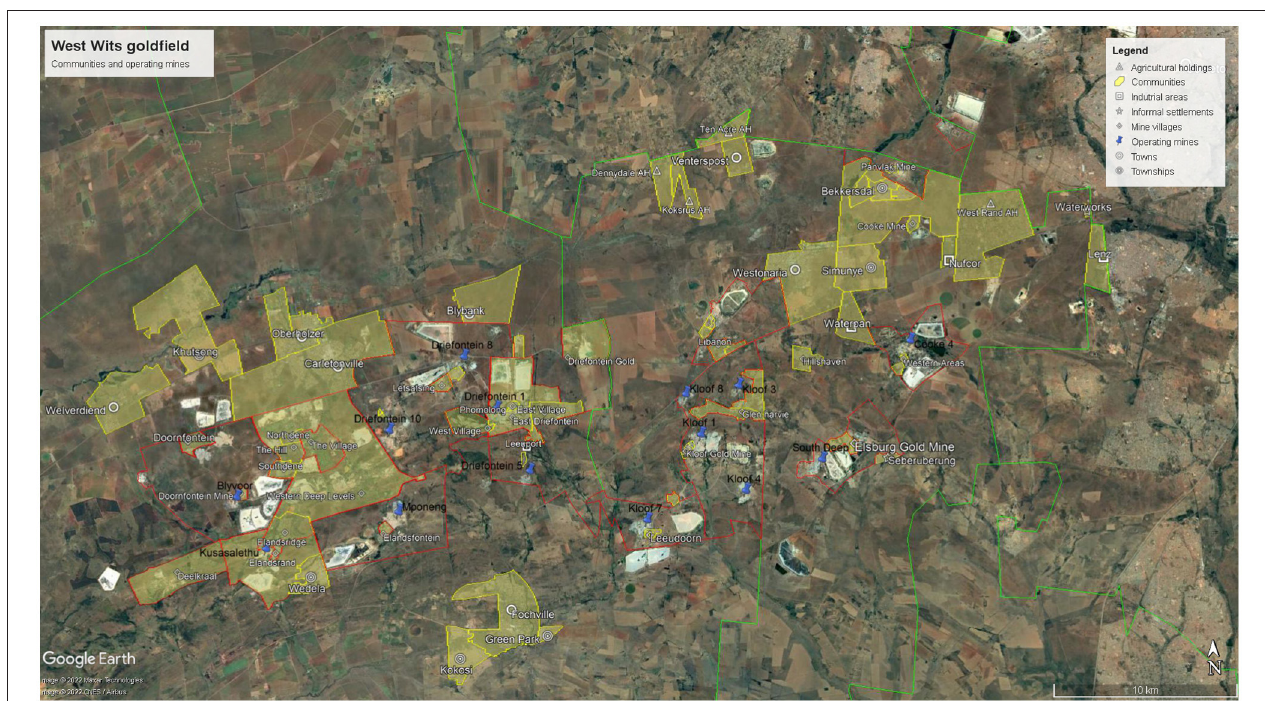
FIGURE 4 | Satellite map of communities (yellow), operating mines (blue pins), mine areas (red borders) and local municipalities (green borders) in the West Wits goldfield (based on Census 2011).